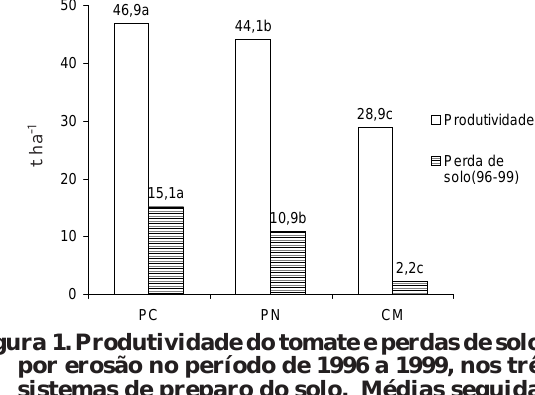
Figura 1. Produtividade do tomate e perdas de solos por erosão no período de 1996 a 1999, nos três sistemas de preparo do solo. Médias seguidas da mesma letra não diferem significativamente pelo teste de Tukey a 5 %. Os dados de perdas de solo por erosão nos anos de 1996 a 1997 foram obtidos por Kunzmann et al. (1998). PC: Plantio convencional; PN: Preparo em nível; CM: Cultivo